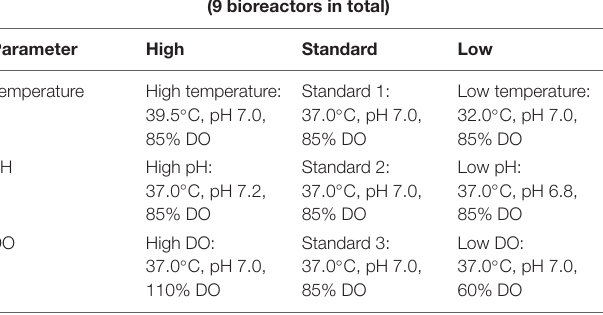
TABLE 1 | Bioprocessing conditions used to prepare CHO DP-12 cell cultures in Sartorius Cultibag Disposable Bioreactors. Applied bioreactor settings once cells entered stationary